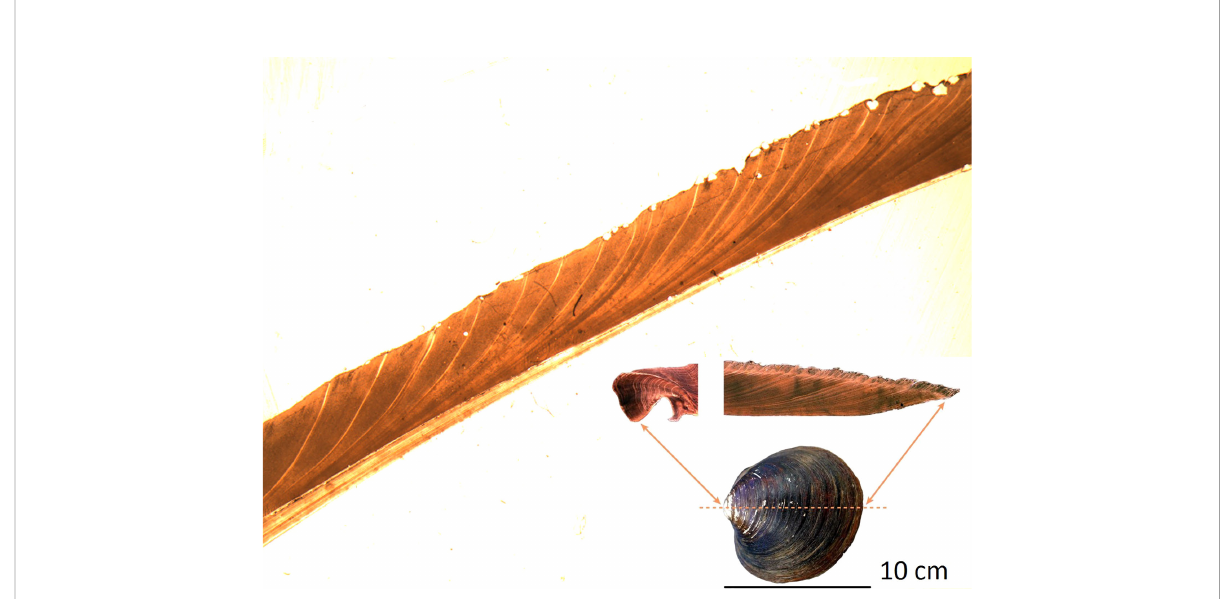
FIGURE 2 Photograph of the growth rings of a part of a typical A. islandica shell on the Faroe